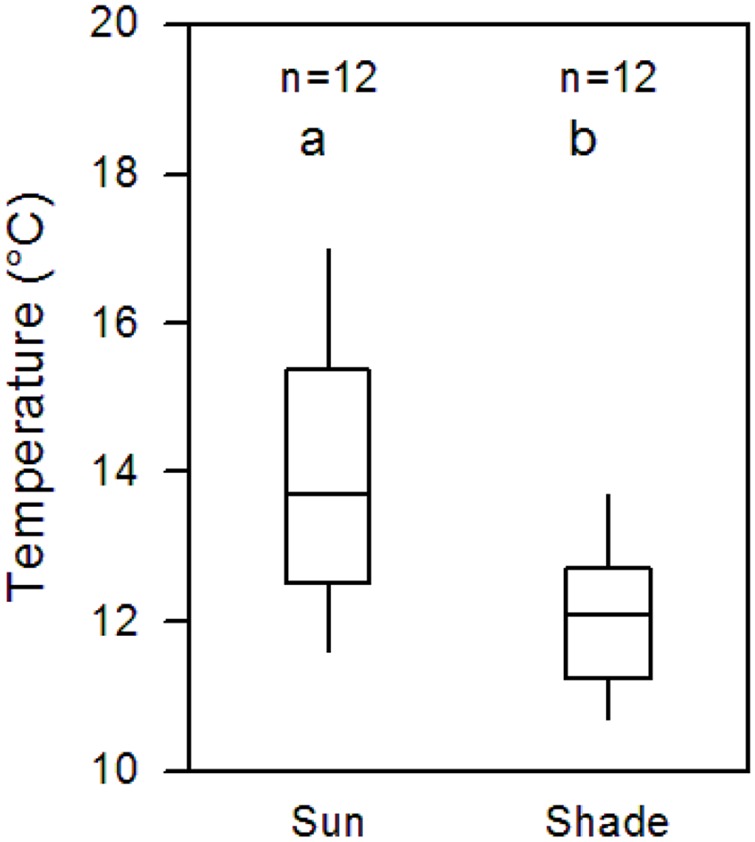
Soil temperature difference between the shaded (north of the stem) and sun-exposed side (south of the stem) of the slope under 12 isolated P. cembra trees. Given are the median and four quartiles of the afternoon temperatures in July and August 2012 (14:00–16:00 solar time) measured in 10 cm soil depth. Both groups are significantly different (p < 0.001; Mann–Whitney U test).